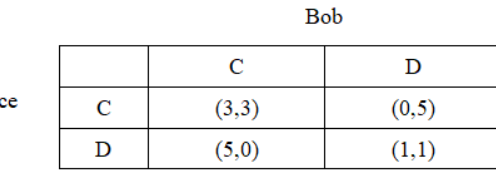
Figure 1. The payoff matrix of the 2-player Prisoner’s Dilemma. The first number in the parenthesis denotes the payoff of Alice, the second number denotes the payoff of